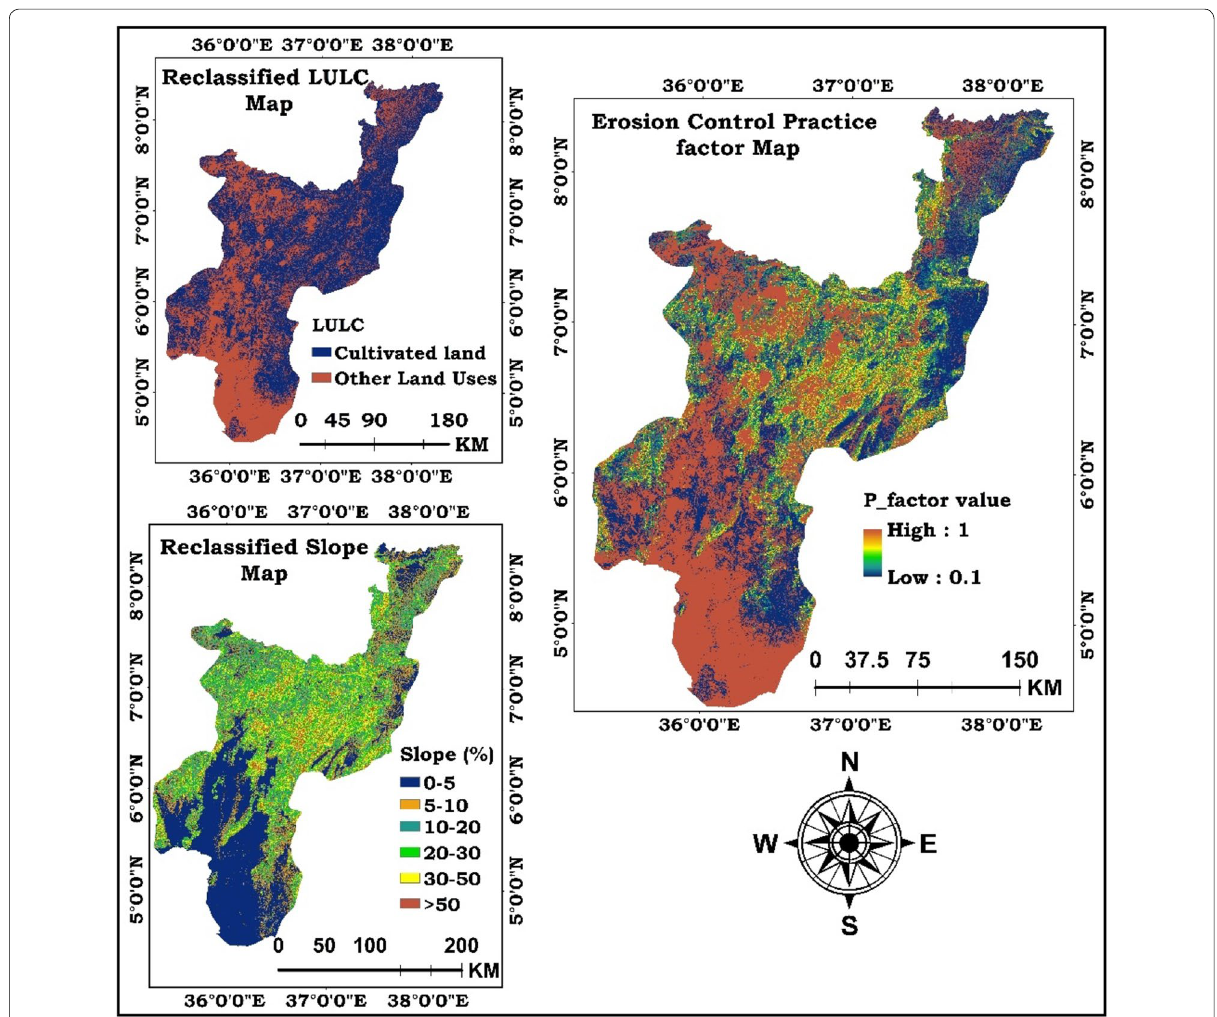
Fig. 7 P factor value (C) produced using reclassified slope and